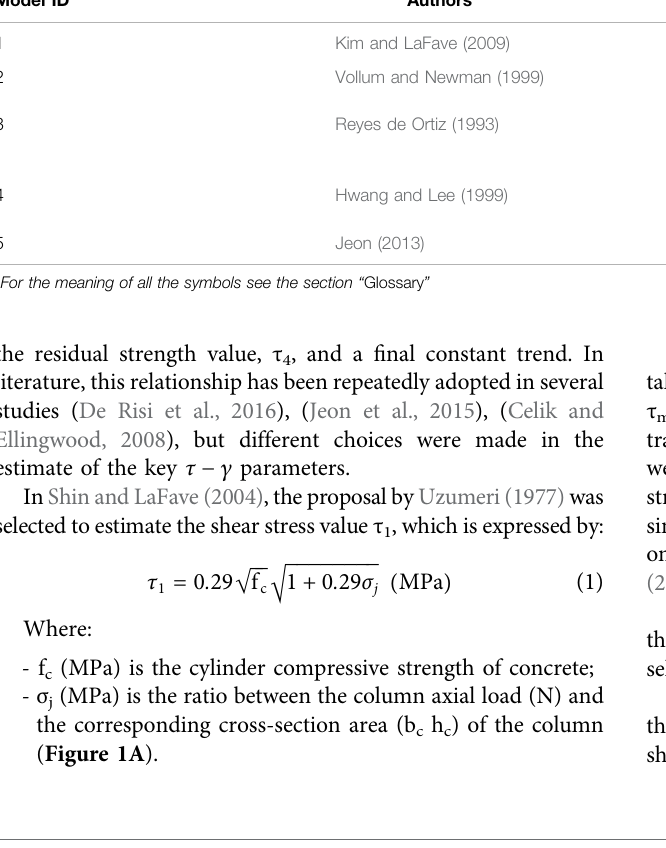
TABLE 1 | Selected literature models for the estimate of peak shear stress τ 3 (cid:2) τ max . Model